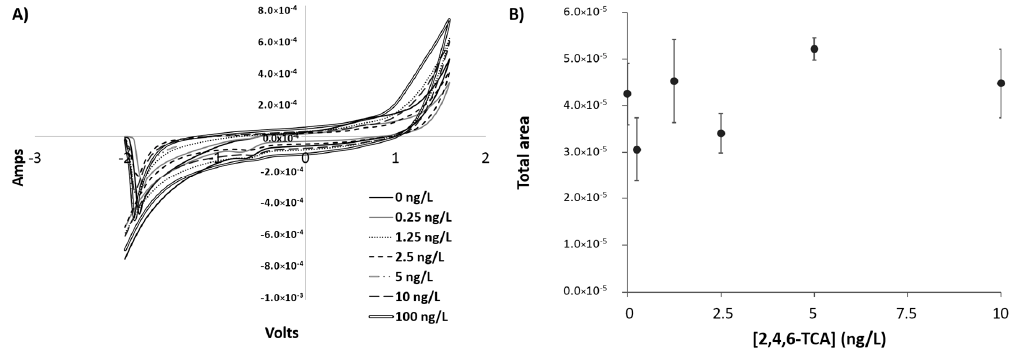
Figure 6. Cyclic voltammograms for H 2 O (100% v / v ) without (0 ng/L, black line) and with 2,4,6-TCA addition (0.25 to 100 ng/L) ( A ); Schematic representation of different 2,4,6-TCA concentrations in real aqueous samples from cork planks boiling treatment, estimated by the proposed CV method ( B